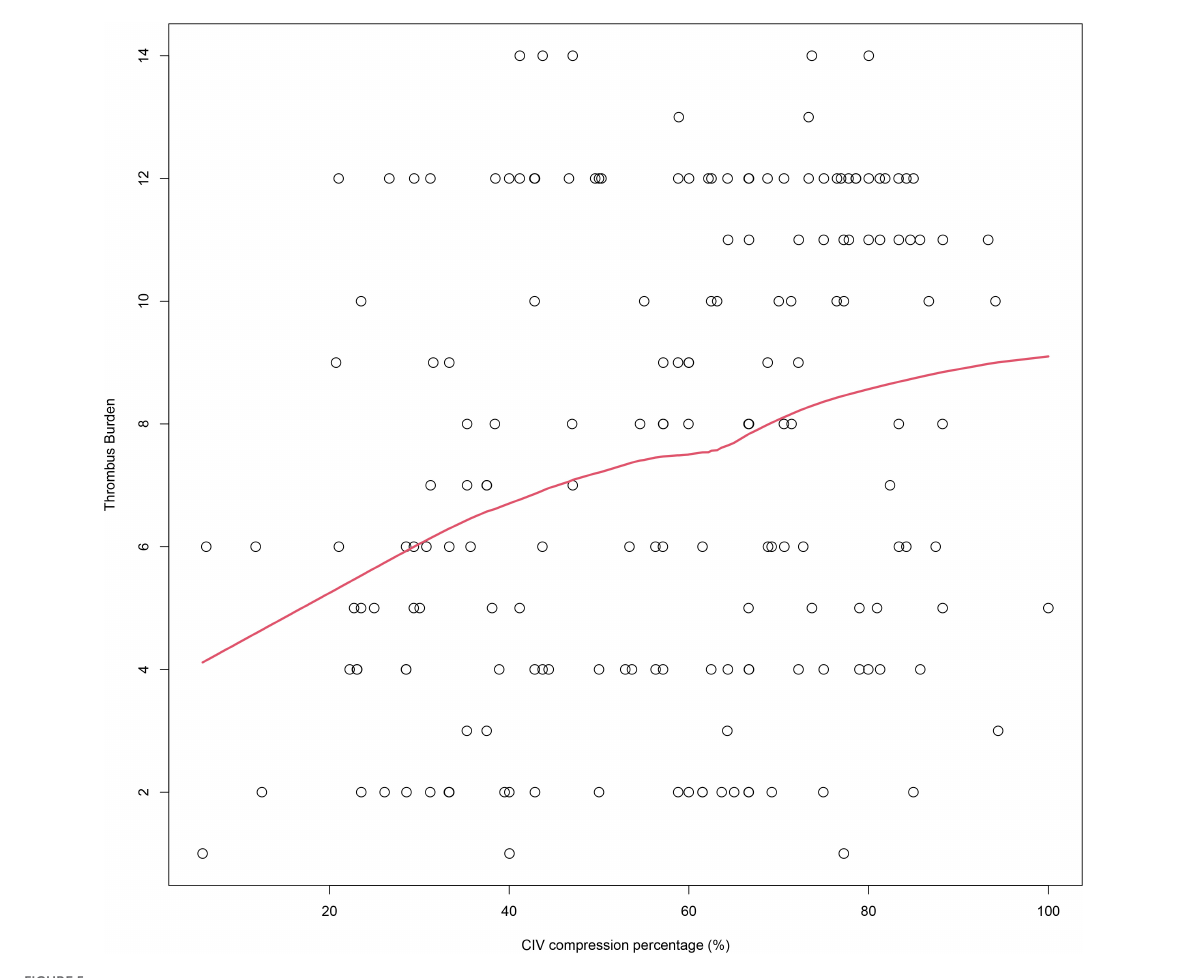
FIGURE5 The LOWESS plots show the association between CIV compression percentage and thrombus burden. LOWESS, locally weighted scatterplot smoothing; CIV, common iliac